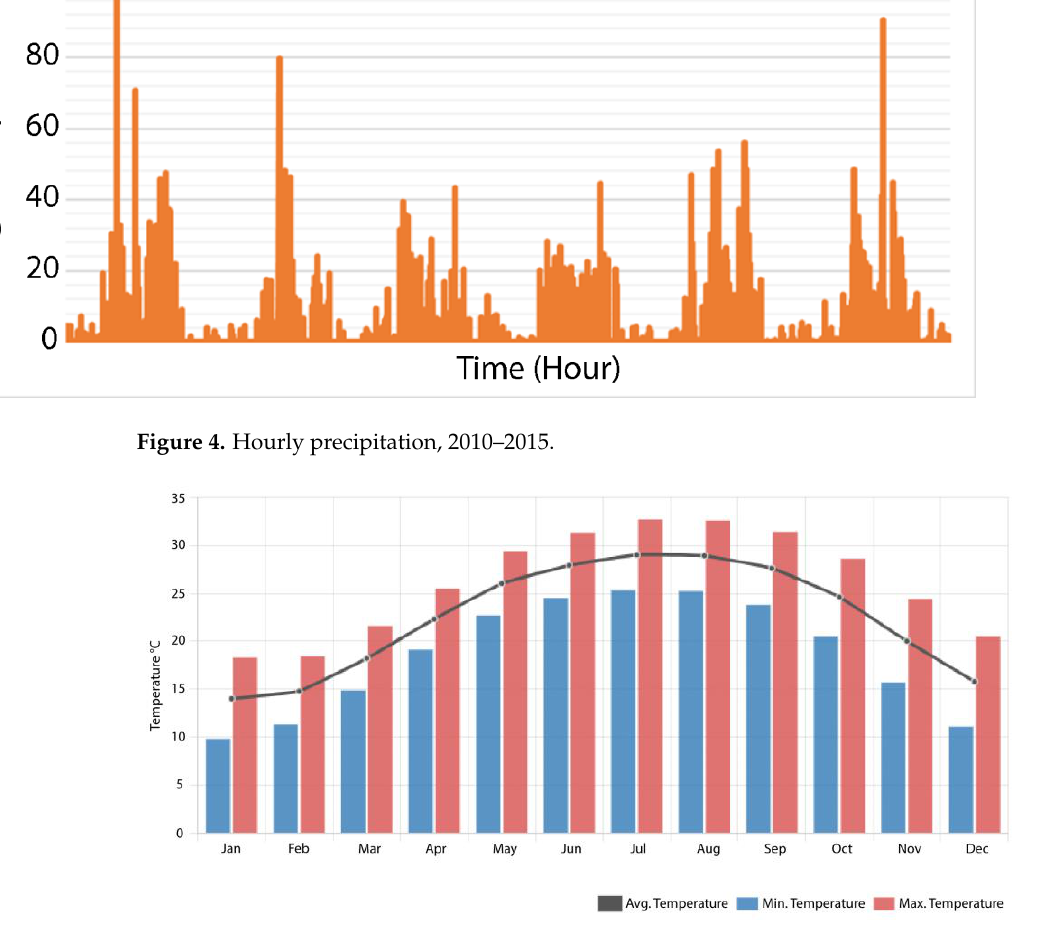
Figure 5. Average monthly temperature, 1961 – 1990.